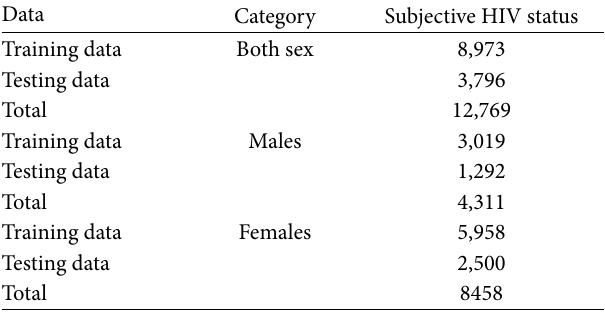
Table 1: Training and testing data used in the